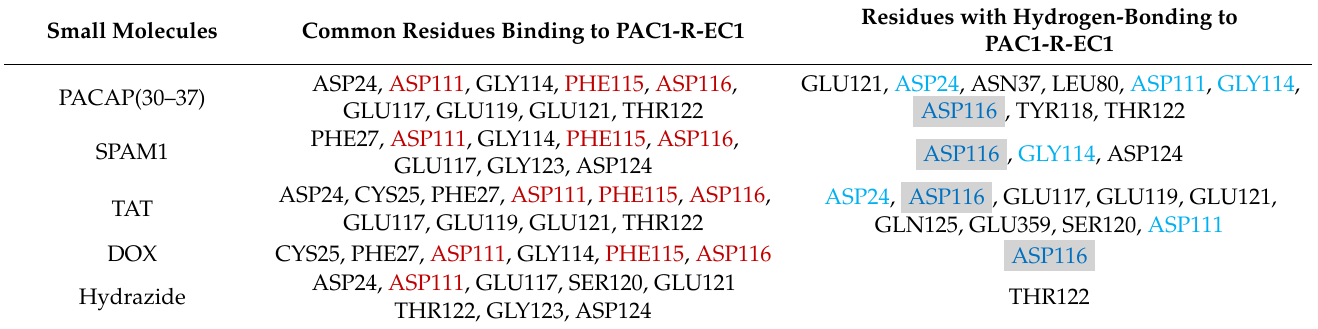
Table 1. The amino acid residues involved in the binding with